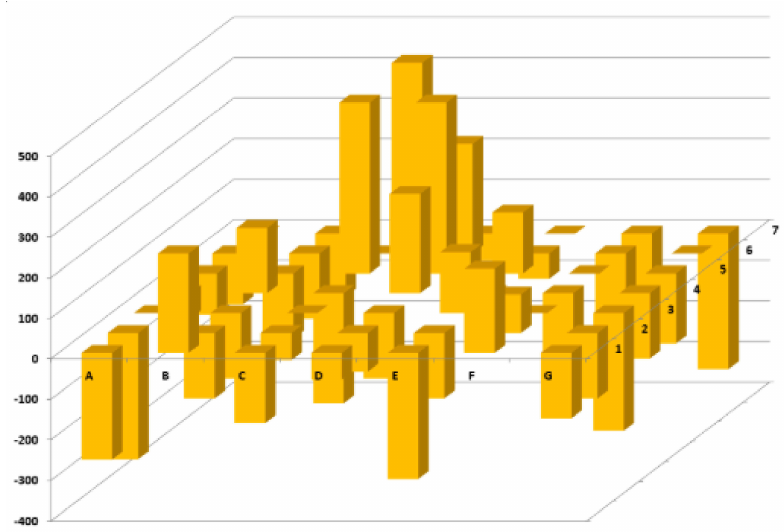
Figure 8. Graph of differences in measured velocities [m · s − 1 ] of ultrasound wave for specimen A2_1 before and after blast load of 475 g